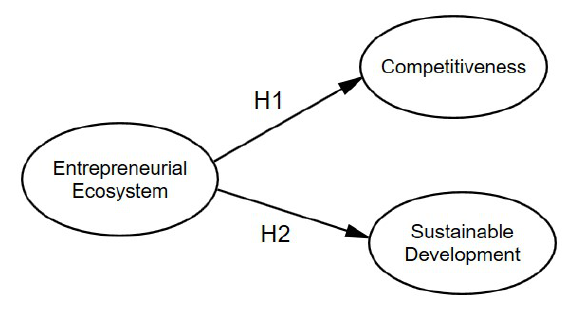
Figure 1. Hypothetical model for structural relationship between ecosystem entrepreneur and competitiveness and of sustainable